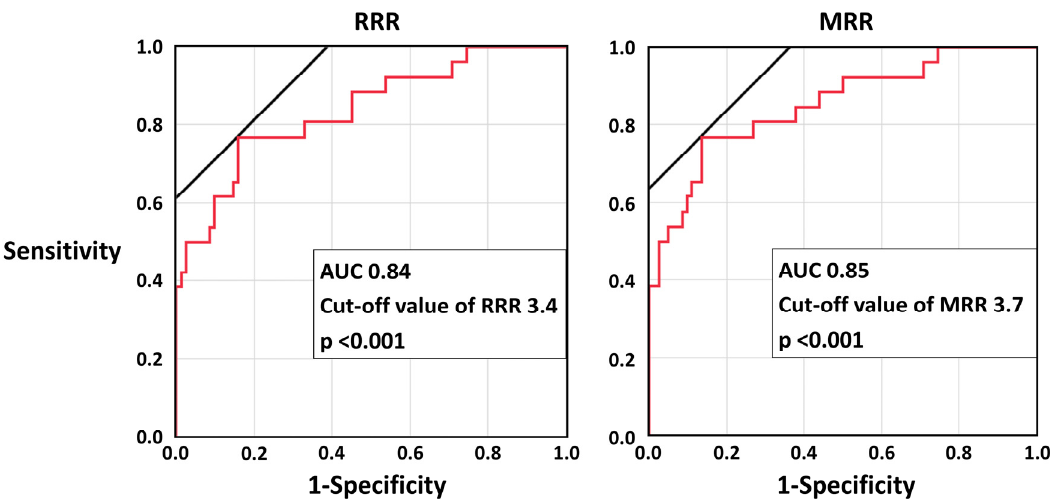
Figure 2. The receiver operating characteristic curve analyses of RRR and MRR for CMD. AUC, area under the curve; CMD, coronary microvascular dysfunction; MRR, microvascular resistance reserve, RRR; resistance reserve ratio.